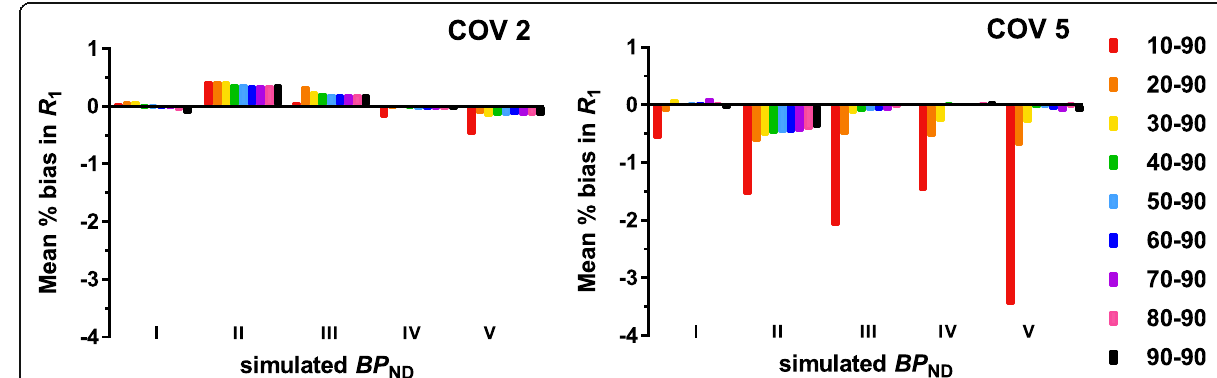
Fig. 5 [ 18 F]flutemetamol: percentage bias in SRTM-derived R 1 across the range of BP sim